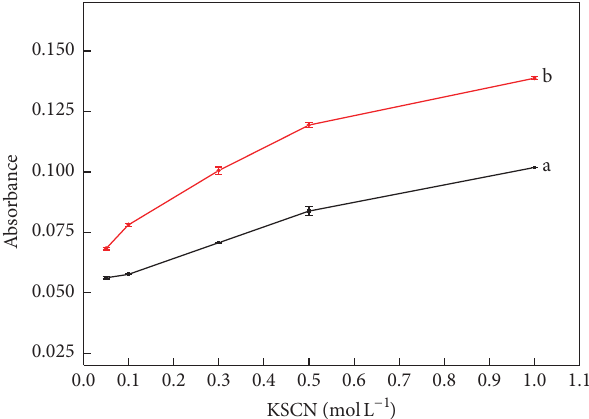
Figure 3: Effect of the potassium thiocyanate concentration. Curves a and b refer to blank and Mo (VI) standard solution (100 𝜇 gL −1 ). Experimental conditions: 0.44 mol L −1 SnCl 2 ; blank and Mo (VI) standard solution in 1.5 mol L −1 HC medium; 7 sampling cycles; sampling time intervals of 2.0 and 1.0 s for insertion sample and SCN − solution, respectively; pumping rate at 50 𝜇 Ls −1